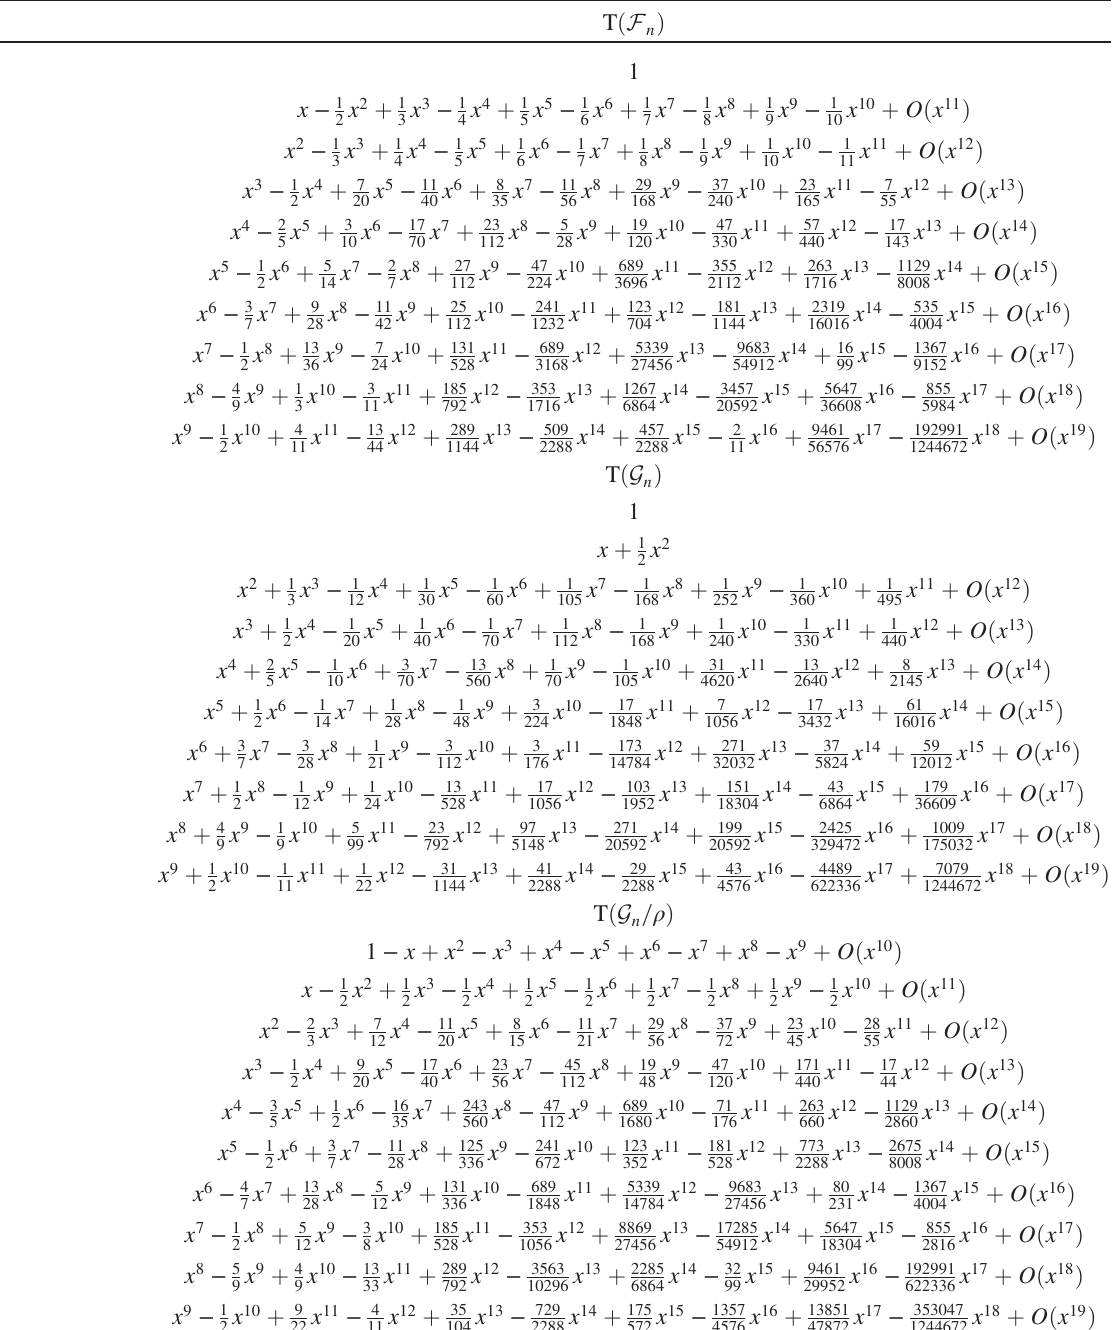
; they are also Taylor polynomials of F n ð ρ Þ , G n ð ρ Þ and G n ð ρ Þ 1 þ x